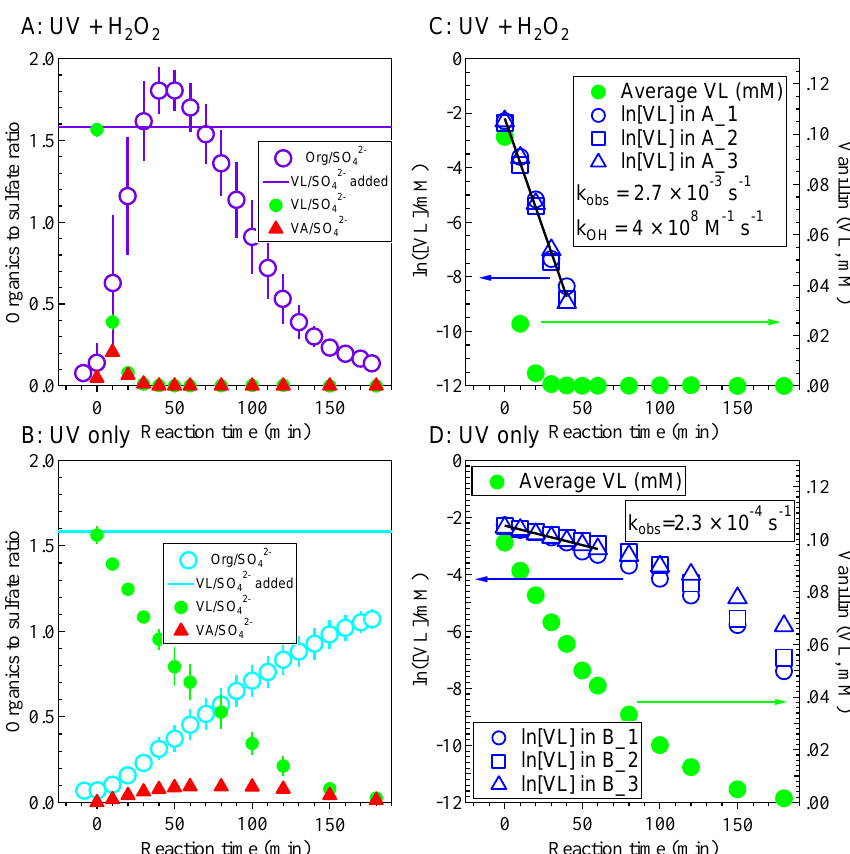
Fig. 4. The ratio of vanillin (VL) to sulfate and the ratio of vanillic acid (VA) to sulfate (panels a and b ), their absolute concentrations in the aqueous solution and the natural log of their absolute concentrations (panels c and d ) under the two reaction conditions. Decay rate constants ( k obs ) were determined at the first 50–60min of the reactions. See main text for the discussion on the rate constant for the bimolecular reaction between VL and OH ( k OH ) for condition (A) in panel (c).